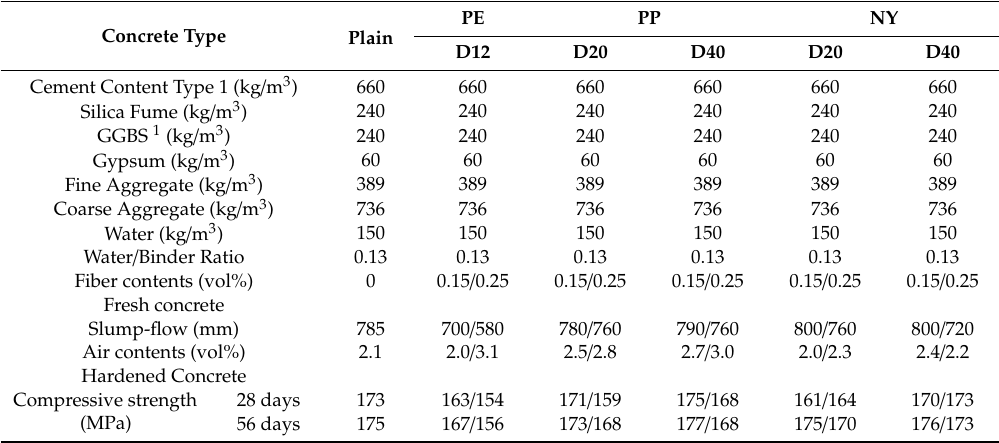
Table 4. Mixture proportions and properties of fresh and hardened